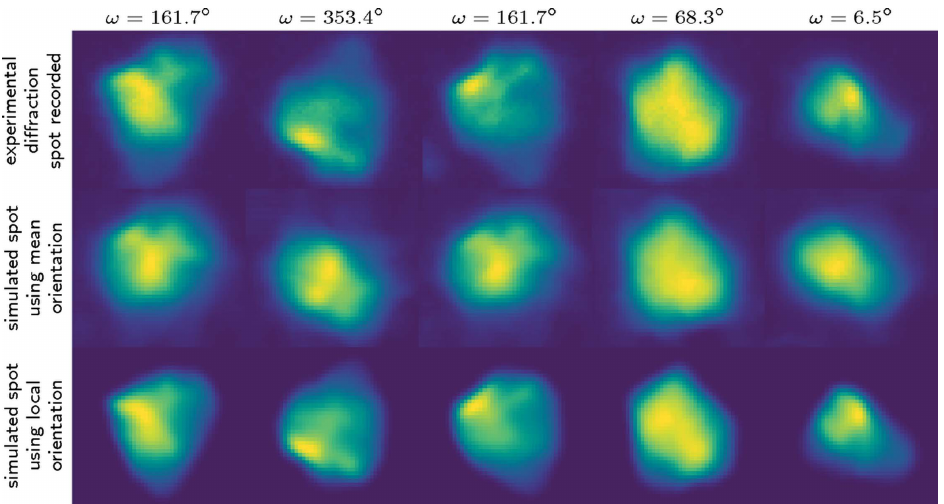
Figure 6 Illustration of the improved reconstruction quality using the local orientation field: experimental spots recorded on the detector for grain 44 are compared with simulated spots from the SIRTreconstruction (second row) and from the 6DTV reconstruction (third row), all images are plotted using arbitrary units and the same scale.